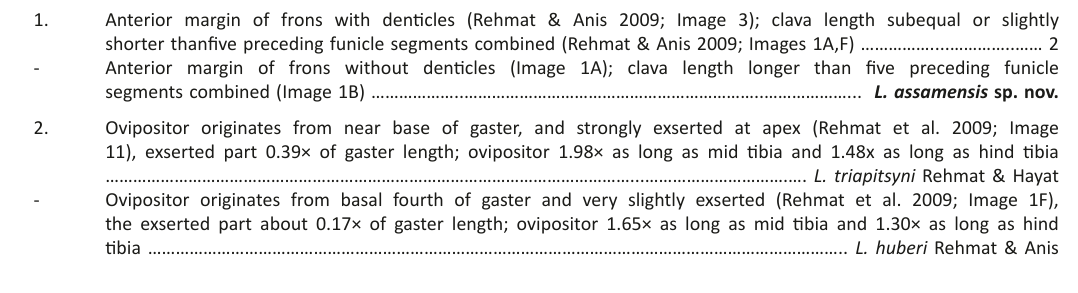
(F1), covered with fine longitudinal striations; all funicle segments longer than broad; F1 and F3 equal in length; F2 longest; F4, F5 and F6 subequal in length; F6 slightly broader than preceding five funicle segments individually; clava about 2.4× as long as wide, much longer than preceding five funicle segments (F2−F6) combined, and with four longitudinal sensillae. Relative measurements of antennal segments; length